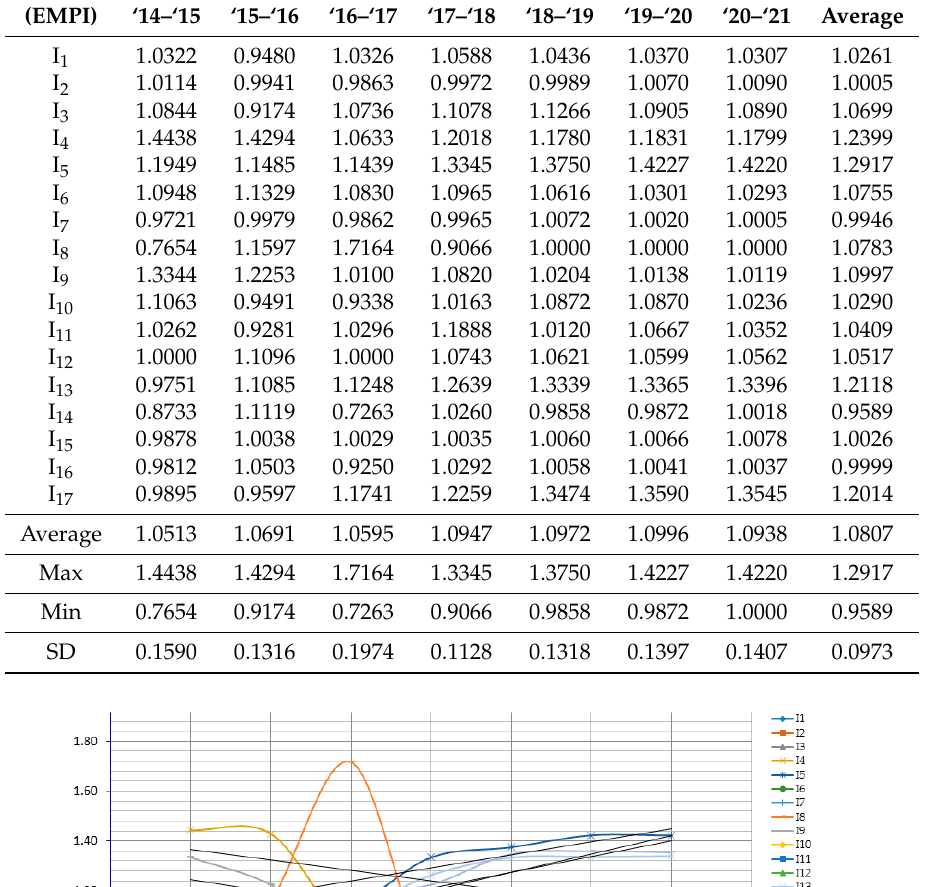
Table 17. Malmquist index.